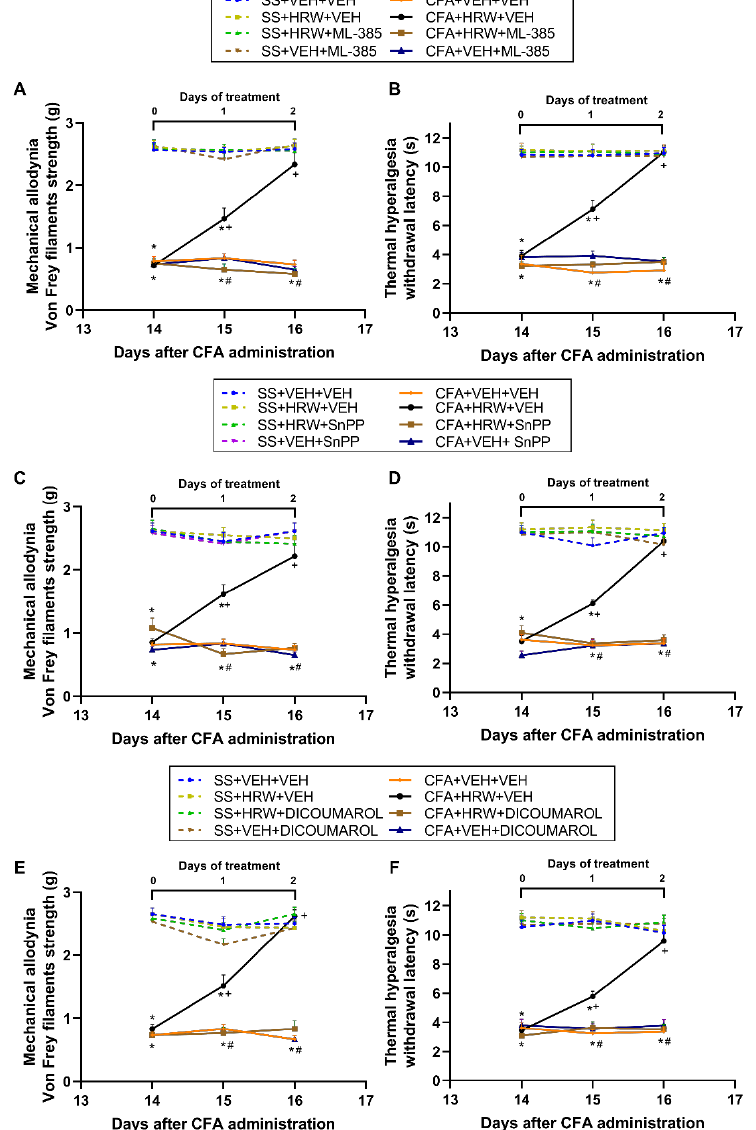
Figure 5. Reversion of the analgesic effects of HRW produced by inhibitors of the Nrf2/HO-1-NQO1 signaling in animals with inflammatory pain. Effects of the intraperitoneal co-administration of HRW with a Nrf2 inhibitor (ML-385, 25 mg/kg) ( A , B ), an HO-1 inhibitor (SnPP, 10 mg/kg) ( C , D ), a NQO1 inhibitor (dicoumarol, 10 mg/kg) ( E , F ), or VEH in the mechanical allodynia ( A , C , E ) and thermal hyperalgesia ( B , D , F ) provoked by CFA in the ipsilateral paws of mice are shown. For each test, * denotes significant differences vs. their respective SS-injected mice, + denotes significant differences vs. CFA-injected mice treated with VEH plus VEH, and # denotes significant differences vs. CFA-injected mice treated with HRW plus VEH ( p < 0.05; one-way ANOVA and Student–Newman– Keuls test). Data are presented as mean values ± SEM; n = 6 animals for group.